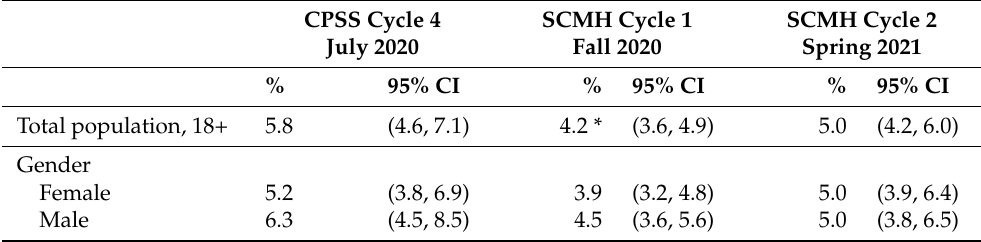
Table 1. Prevalence of concern about violence in individuals’ own homes, by gender, population aged 18 or older, Canada, 2020 and 2021. CPSS Cycle 4 SCMH Cycle 1 SCMH Cycle